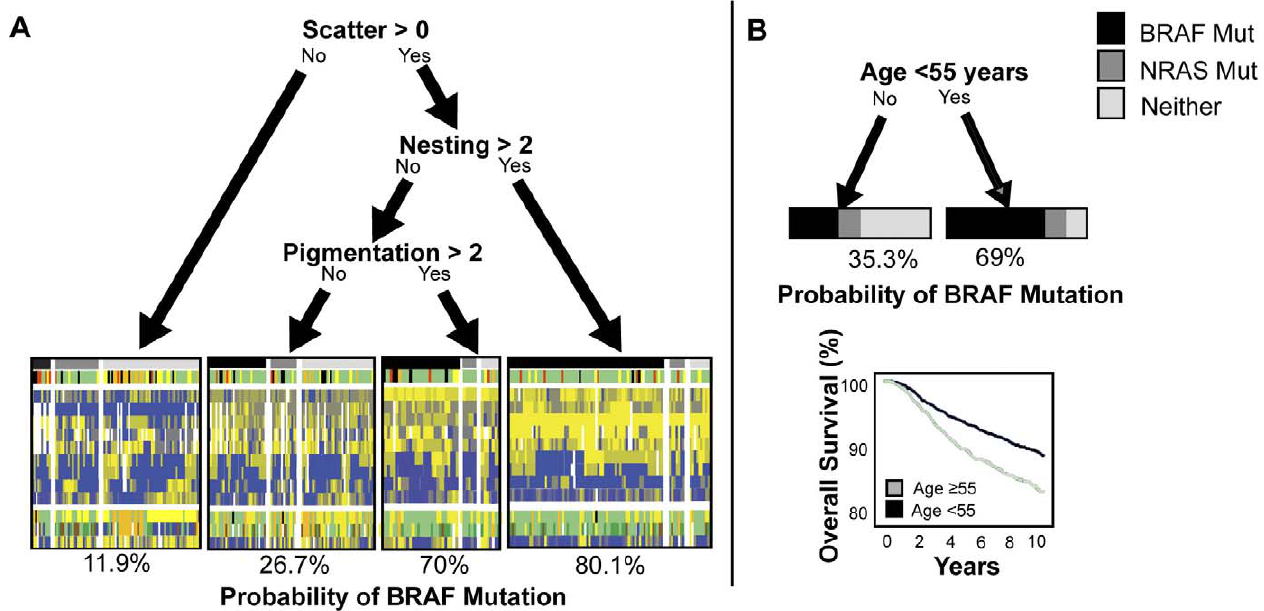
Figure 3. Prediction Algorithms of BRAF Mutation Prediction trees for BRAF mutation status with morphologic variables (A) or variables in the Southern German Tumor Registry (B). (A) Terminal nodes display heatmaps showing samples by mutation status, ordered and coded as in Figure 2A. (B) The prediction tree for BRAF mutation using the variables of age, sex, body site, and WHO type also recorded in melanoma registries identifies an age cutoff of 55 y as the single best predictor of BRAF mutation status. Kaplan Meier survival analysis from the Southern German Tumor Registry shows a significant ( p , 0.0001) decrease in survival when stratified by this age cutoff.